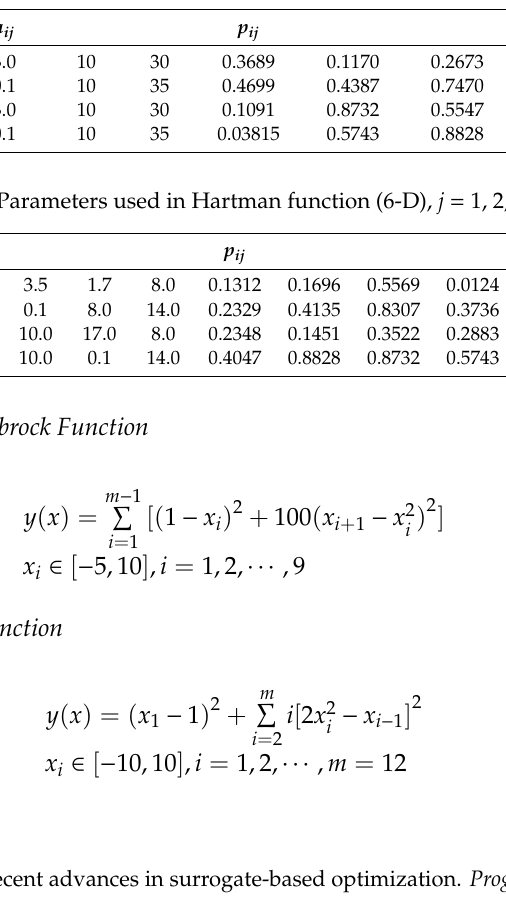
Table A1. Parameters used in Hartman function (3-D), j = 1, 2, 3.